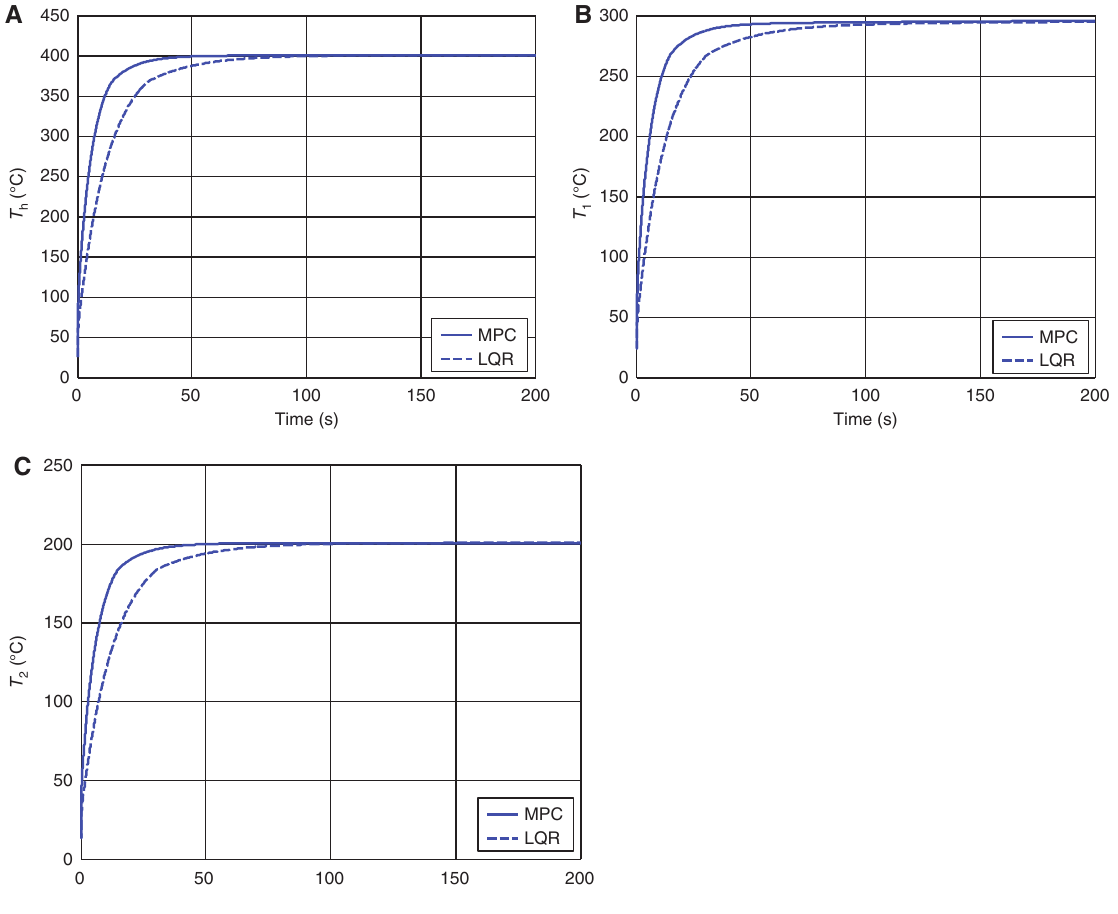
Figure 6 Simulation results for MPC and LQR methods for (A) T